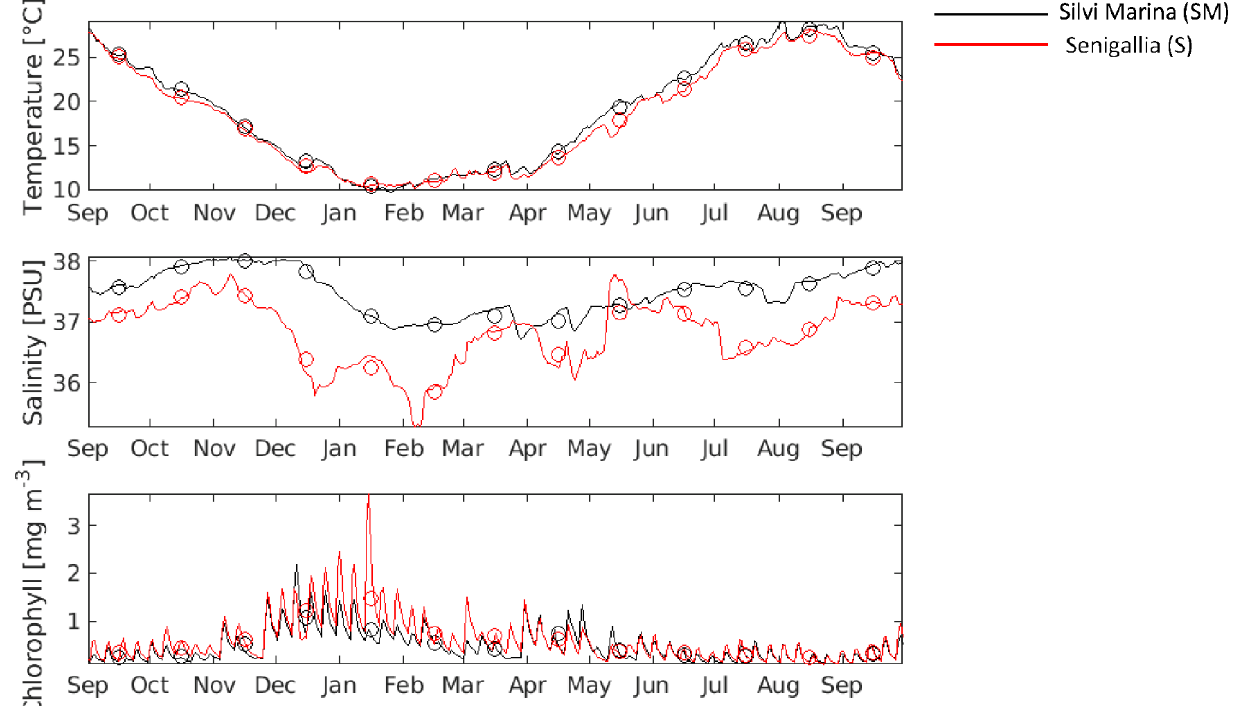
Figure 4. Timeseries of environmental parameters. Daily temperature, salinity, and chlorophyll at the sampling stations of Senigallia (S, red line) and Silvi Marina (SM, black line) were reported. Computed monthly means are superimposed as circles.